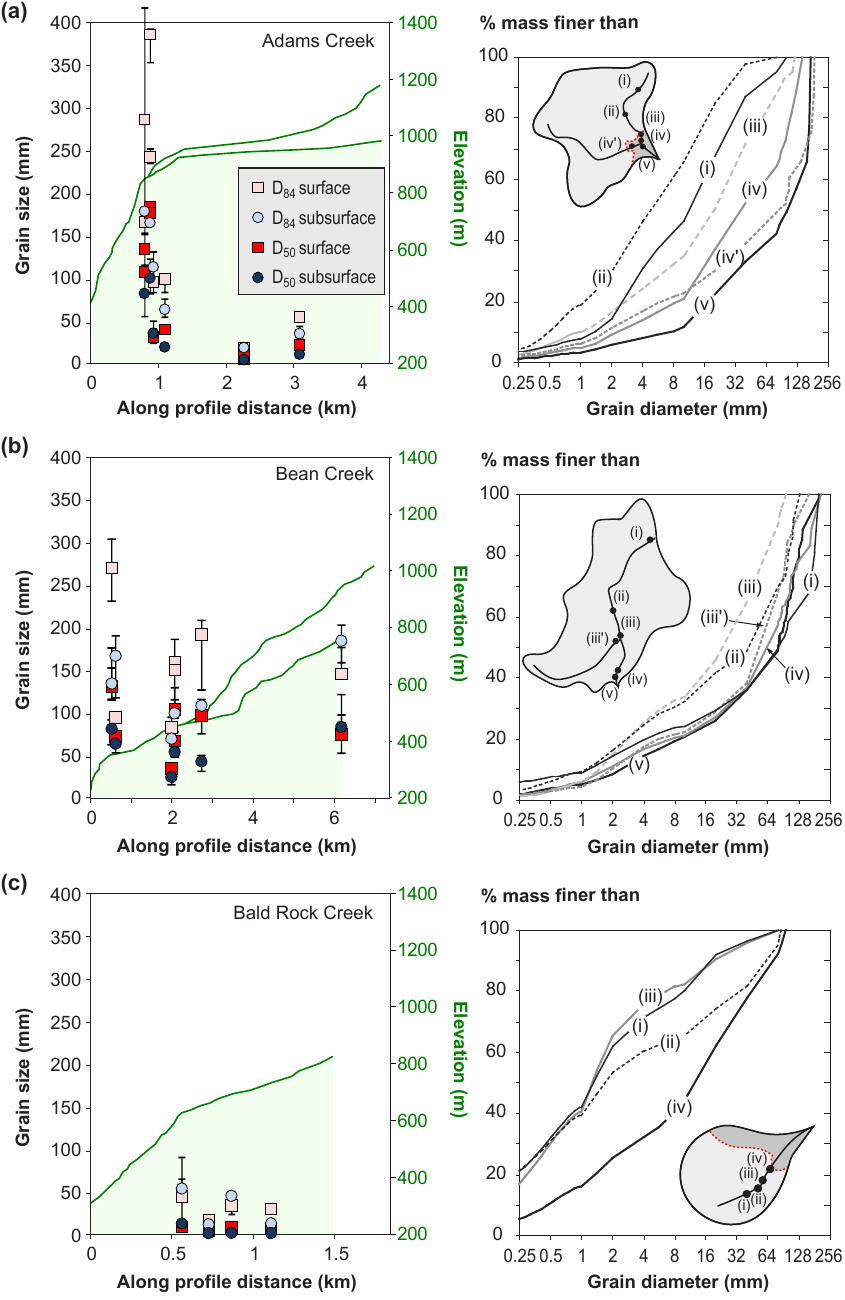
Figure 9. Grain size of the fluvial sediment along (a) Adams Creek, (b) Bean Creek and (c) Bald Rock Creek. Left panels: D 50 and D 84 measured along the rivers (subsurface and surface). Error bars represent plus or minus values calculated according to procedure described in Sect. 2.3. River profiles are shown in green; note change in scale on the x axis. Right panels: cumulative grain size distribution of subsurface sediment (note the log 2 scale on the x axis). Inset grey shapes are schematic map representations of the basins showing the distribution of the samples – (i) being the site the further upstream; transition from plateau to steepened landscape is highlighted by shading and the red dotted line, except in Bean Creek, where there is no clear